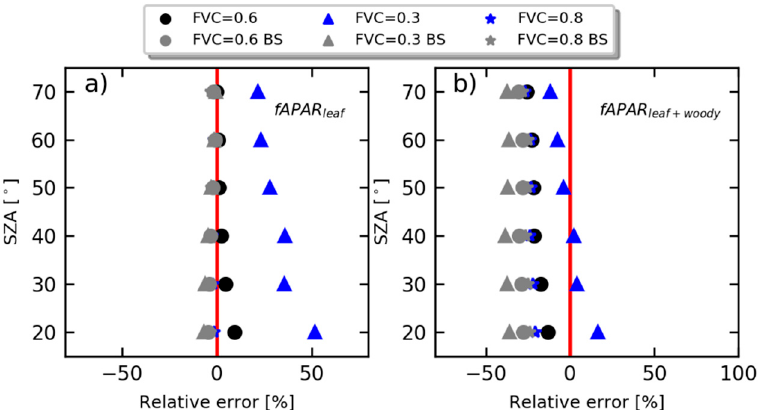
Figure 8. Comparison of SIF escape probability estimated by SIT using fAPAR leaf ( a ) and fAPAR leaf + woody ( b ) as input parameter with reference values that were simulated by DART (i.e., f esc − f esc was calculated as ( f esc ) / f esc SIT DART DART